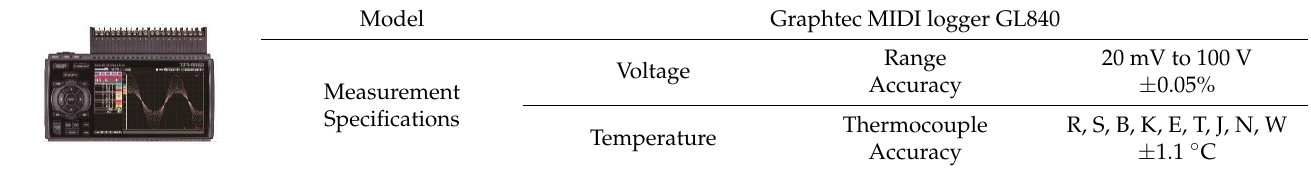
Table 7. Mass flow meter specification.